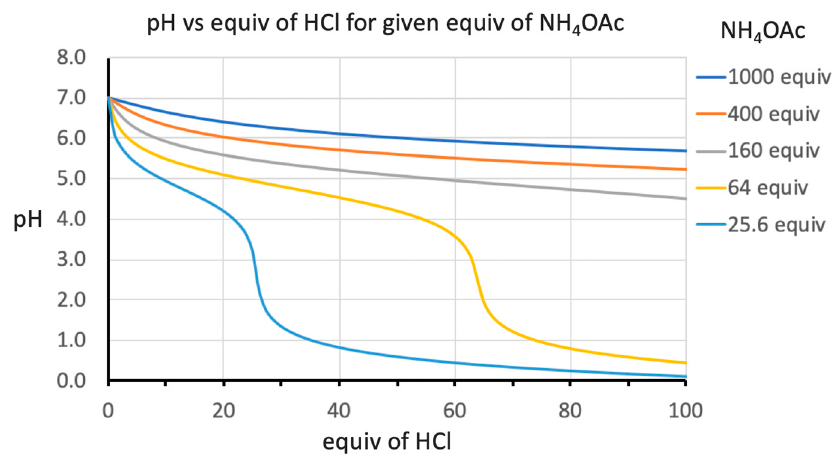
Figure A1. The pH in an ideal solution for given quantities of NH 4 OAc (1000–25.6 equivalents) and HCl (0–100 equivalents). All equivalents are relative to the nitro substrate (set at 10 mM).